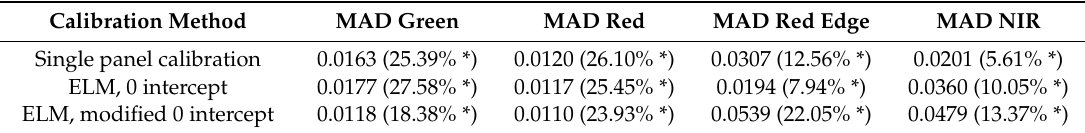
Table 3. MAD of Sequoia derived HCRF values per band for the three calibration approaches, estimated from the comparison with HyPlant HCRF values.